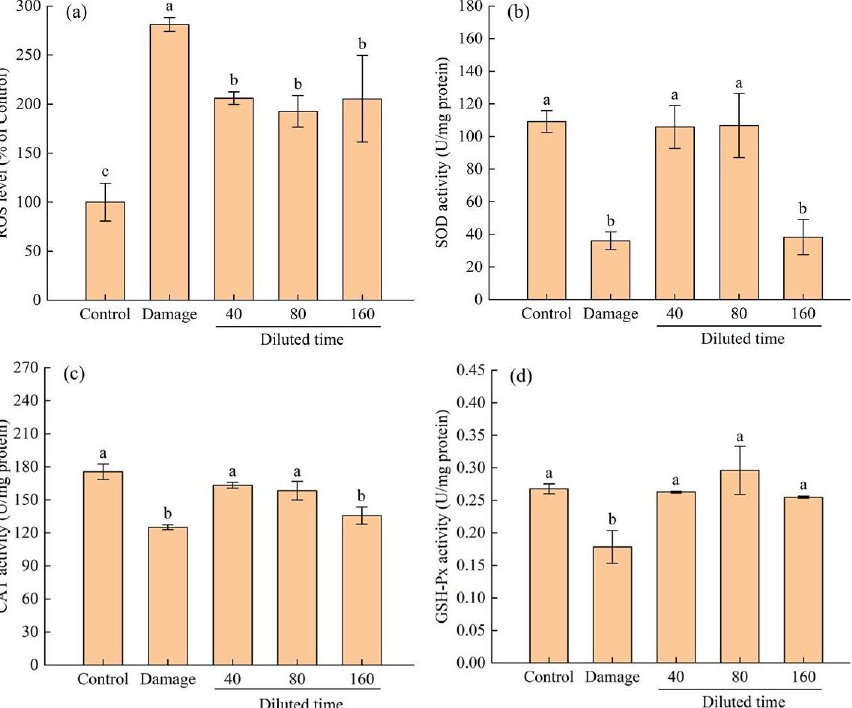
Figure 6. Fermented edible grasses of different diluted times on ( a ) ROS level, ( b ) SOD activity, ( c ) CAT activity, and ( d ) GSH-Px activity in HepG2 cells. The bars with different letters indicate significant differences ( p < 0.05).